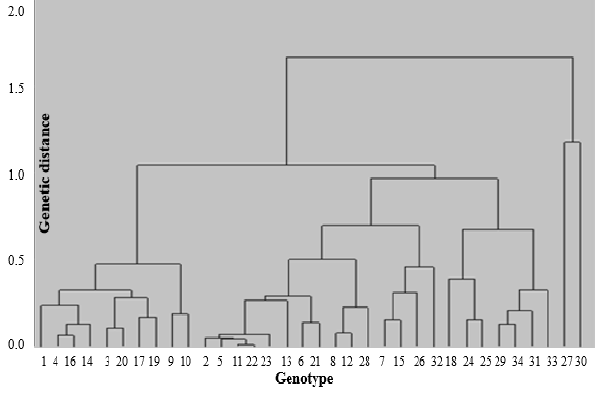
Fig. 5. Tree dendrogram of 34 wheat